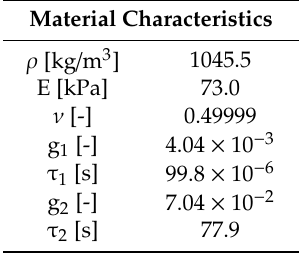
Table 1. Summary of the viscoelastic material characteristics of polyvinyl alcohol (PVA)